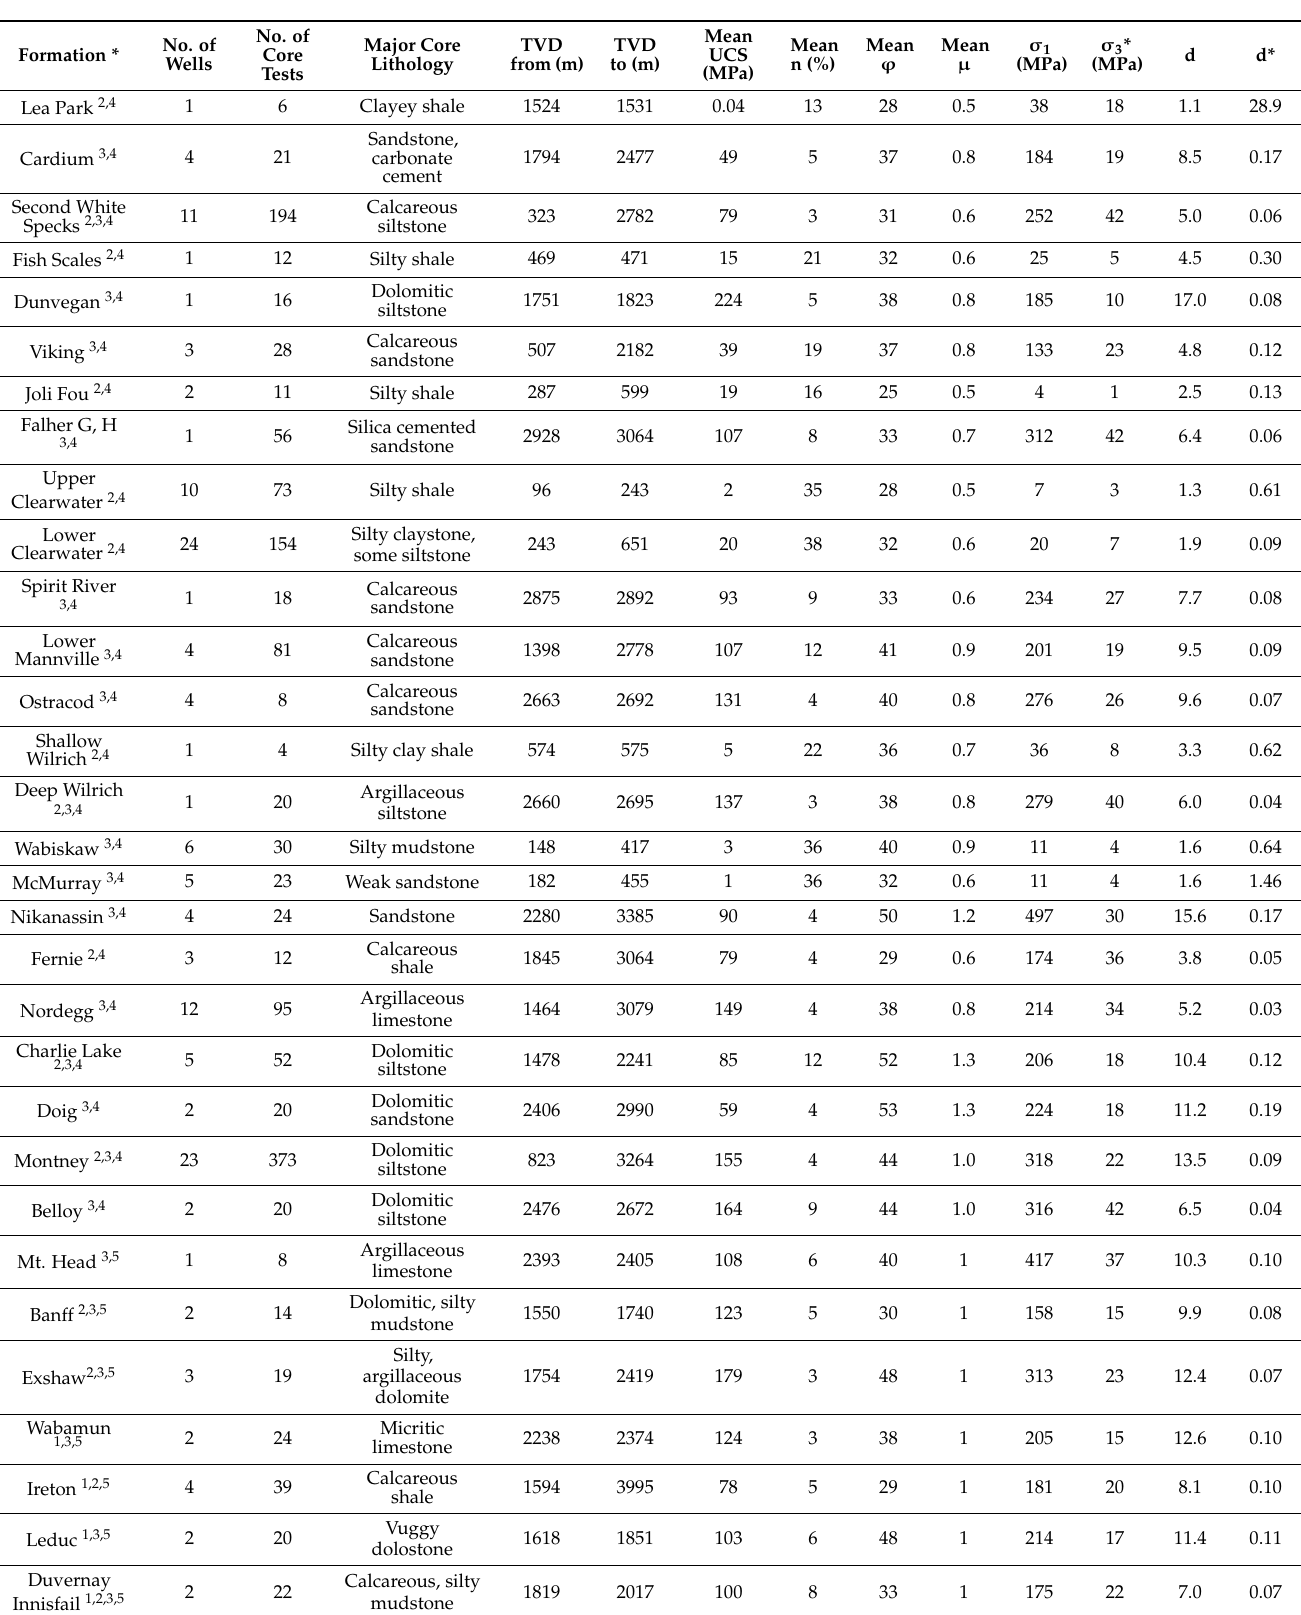
Table 3. Summary of laboratory triaxial test data, empirical and modified Mogi ductility parameter for major injection and confining formations in the Alberta